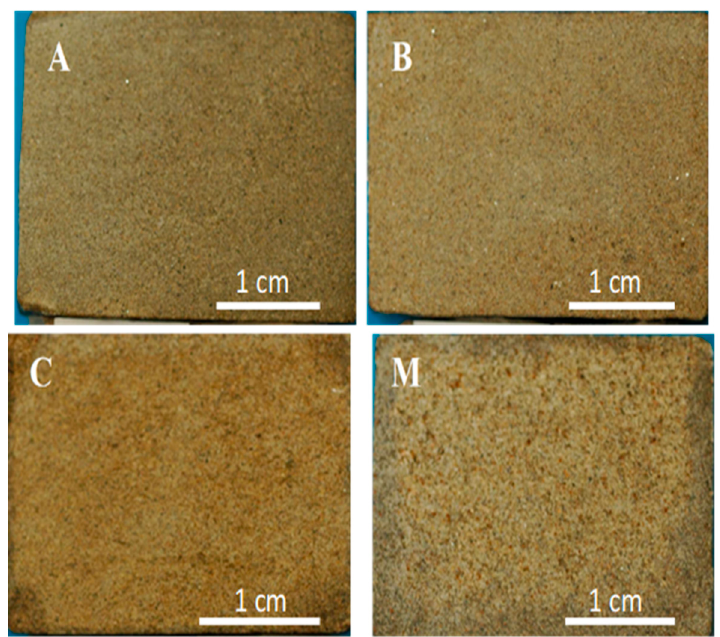
Figure 3. Hand specimen view of the four varieties of sandstone A, B, C, and M collected close to the monuments, identified on images. These varieties have average values of water absorption coefficient of, respectively : 0.8 kg/m 2 h 1/2 , 2.4 kg/m 2 h 1/2 , 6.2 kg/m 2 h 1/2 , and 26 kg/m 2 h 1/2 .